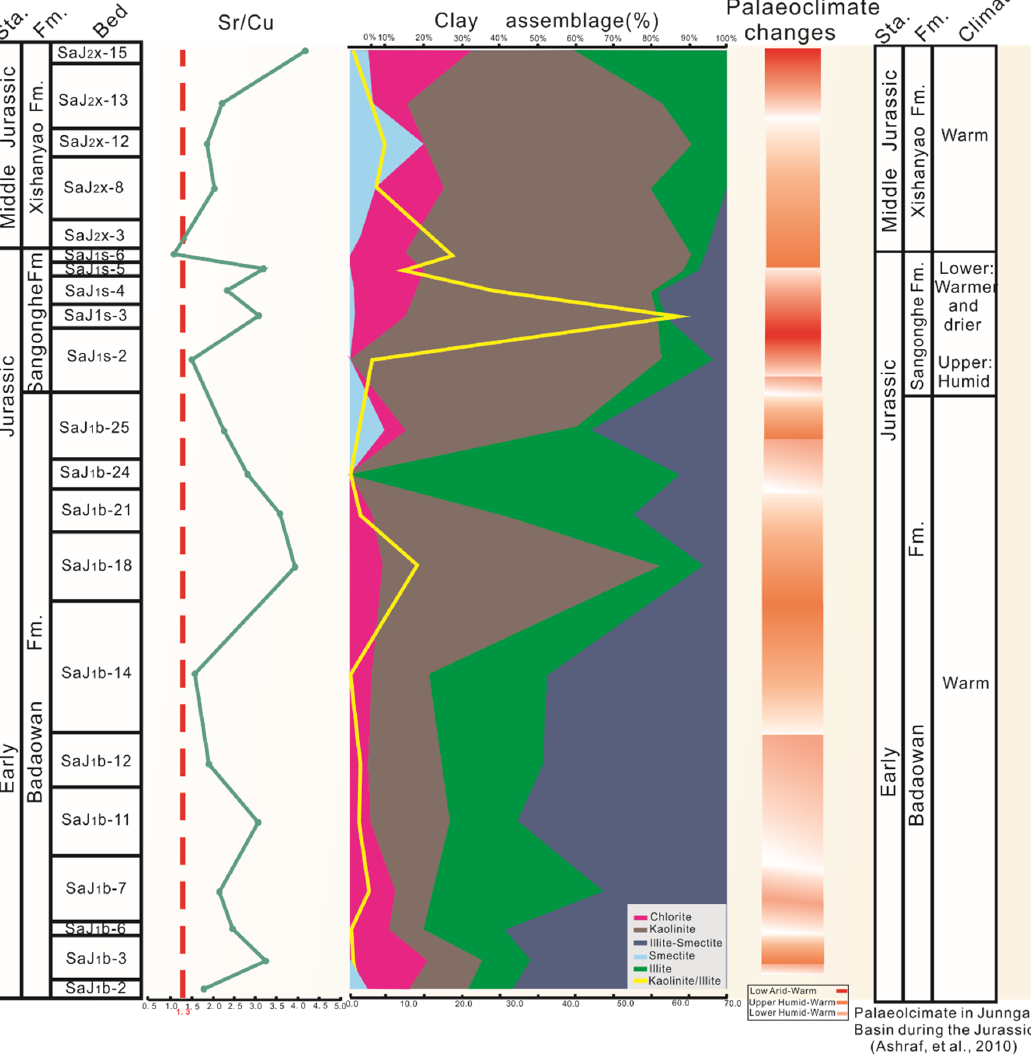
Figure 7. Summary of variations in the clay mineral content and in the trace element ratios and of paleoclimatic changes from the Su’asugou section, Yili Basin, Northwest China. Paleoclimate in Junggar Basin from (Ashraf, et al., 2010) [89].